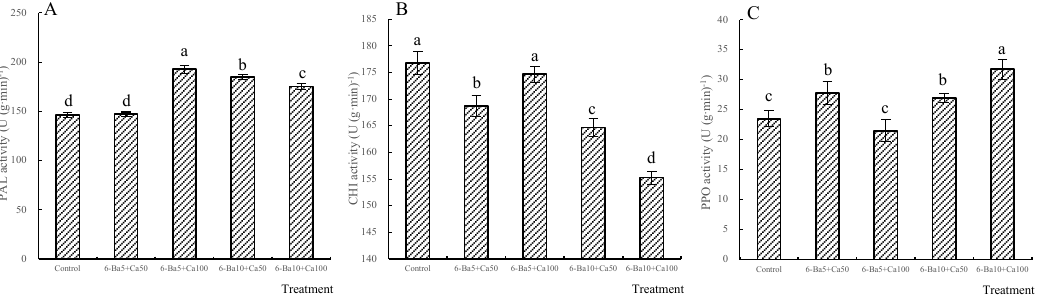
Figure 3. Changes of key enzyme activity of Hangbaiju flower. PAL activity ( A ), CHI activity ( B ) and PPO activity ( C ). Control: water + decapitation; 6-BA 5 + Ca 50 : 5 mg/L 6-BA + 50 mg/L Pro-Ca; 6-BA 5 + Ca 100 : 5 mg/L 6-BA + 100 mg/L Pro-Ca; 6-BA 10 + Ca 50 : 10 mg/L 6-BA + 50 mg/L Pro-Ca; 6-BA 10 + Ca 100 : 10 mg/L 6-BA + 100 mg/L Pro-Ca. Different letters indicate significant differences ( p < 0.05) according to the Tukey’s test. The error bars represent the standard error of the mean (n = 5).